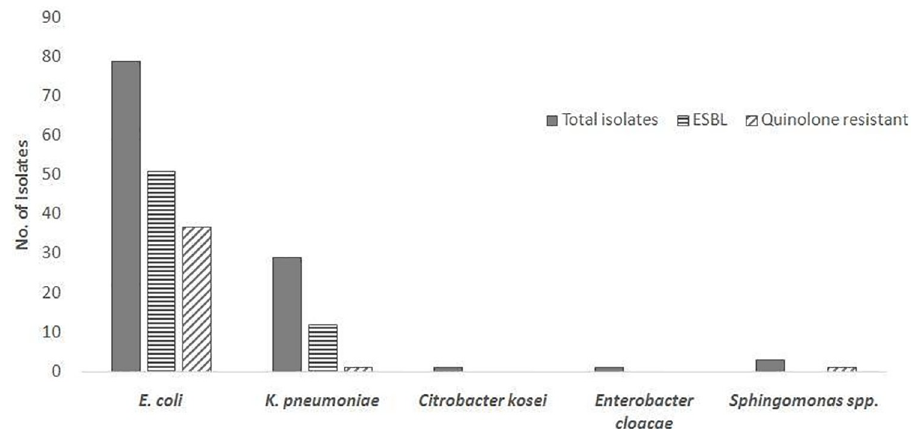
Fig 3. Phenotypic distribution of ESBL and quinolone resistance among isolates. High levels of ESBL and quinolone resistance were observed among E . coli isolates. K . pneumoniae isolates demonstrated less but still substantial resistance.